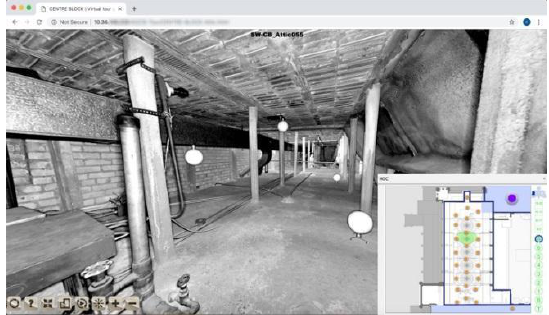
Figure 9: Lidar intensity value panoramic image (with key plan) of an attic space with limited to no lighting, showing visual information about the structure.